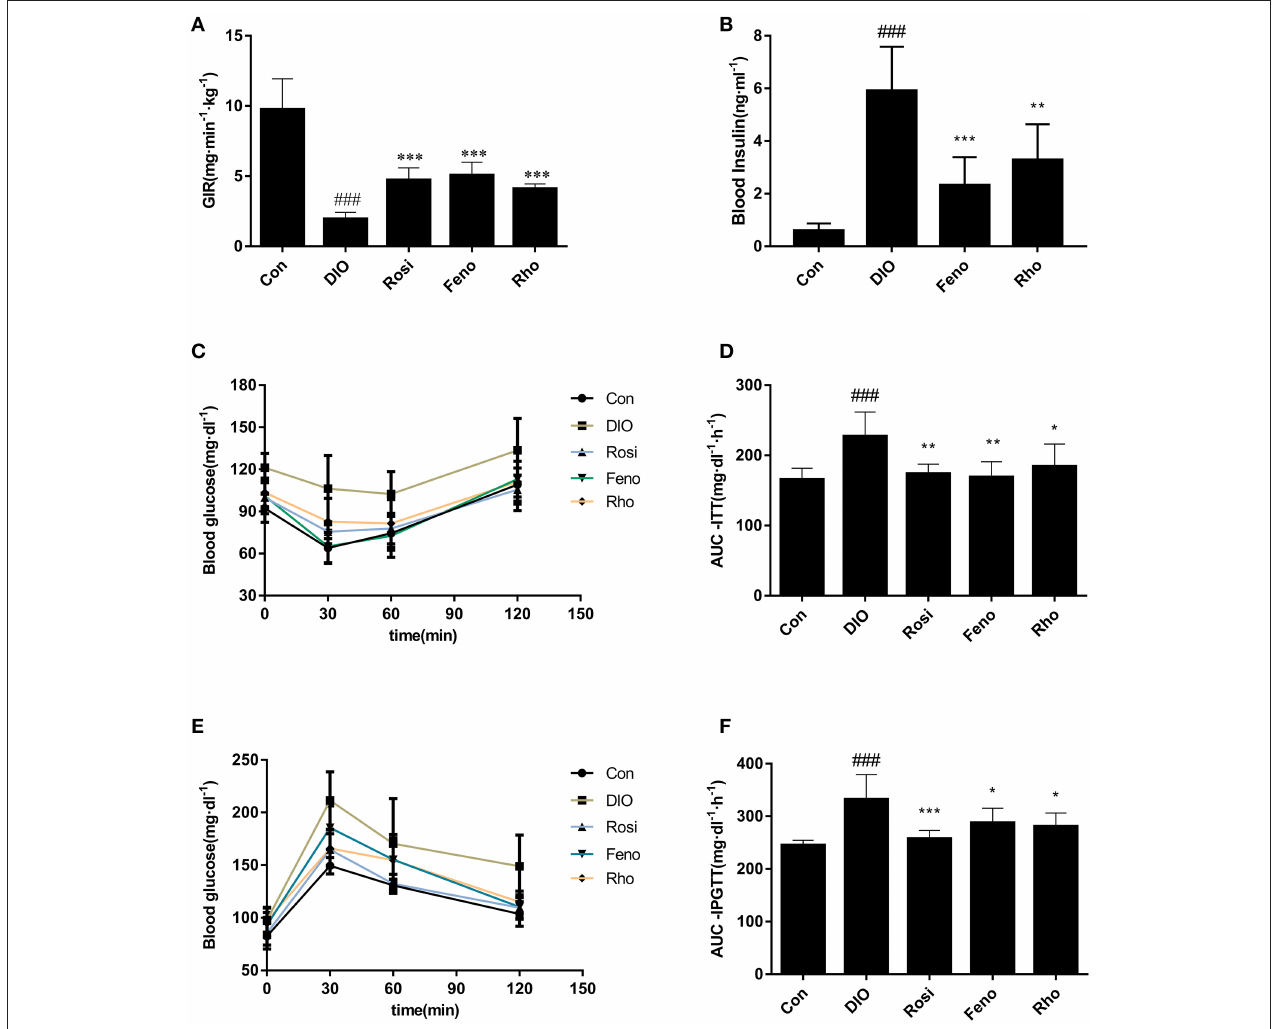
FIGURE 3 | Effects of Rho on insulin resistance in high-fat-diet induced DIO mice. (A) Values of GIR in hyperinsulinemic-euglycemic clamp test. The DIO mice were administrated with Rho (200 mg/kg) for 20 days. Both rosiglitazone (Rosi, 10 mg/kg) and fenofibrate (Feno, 10 mg/kg) were used as the positive control. After fasting for 4h, the animals were infused insulin at 60 pmol/kg/min rates and 10% glucose at different rates for clamping the level of blood glucose at 95 ± 5 mg/dl. (B) Changes of fasting plasma insulin. (C) Changes of blood glucose levels in ITT. (D) Values of AUC-ITT. E, Changes of blood glucose in IPGTT. (F) Values